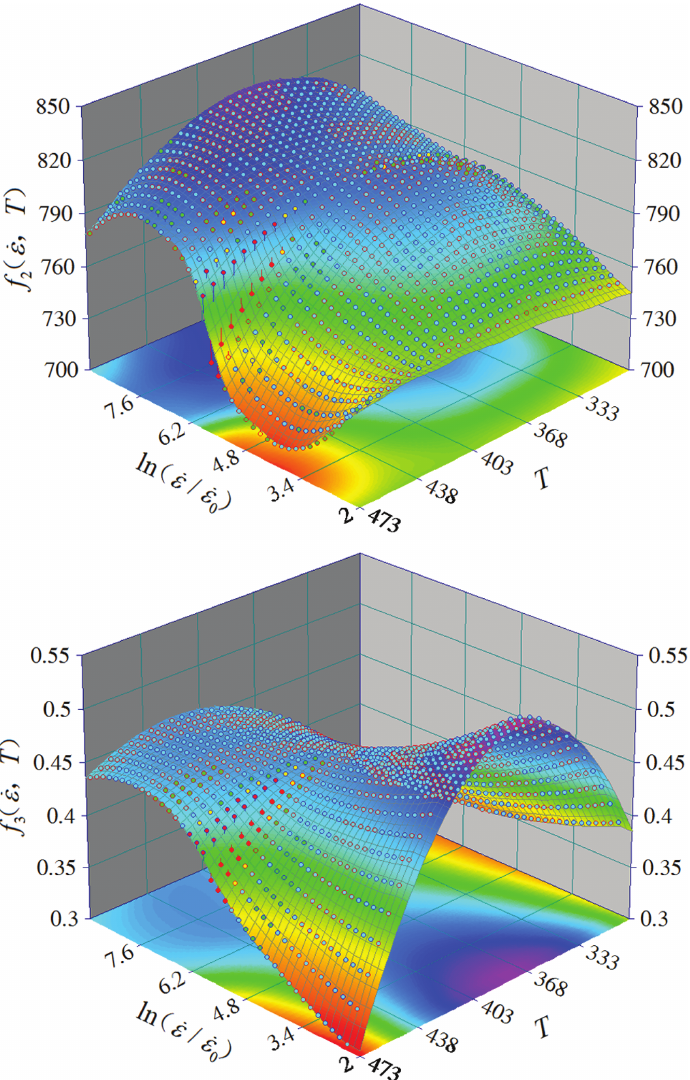
Figure 17: Fitting results of f 2 ð _ ε , T Þ and f 3 ð _ ε , T Þ at low temperature range.